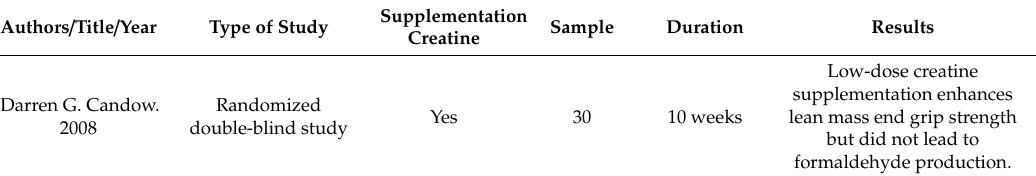
Table 5. Creatine monohydrate.